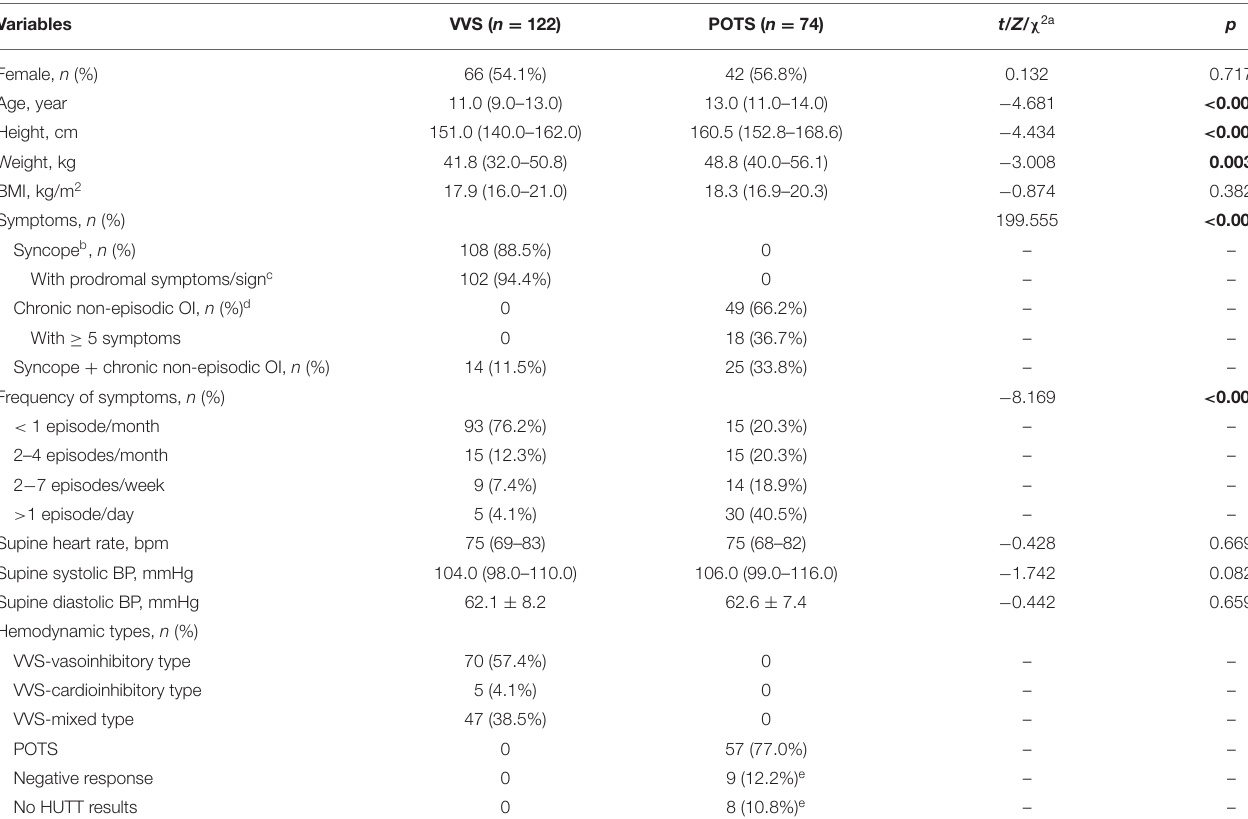
TABLE 1 | Comparison of baseline characteristics between VVS and POTS cases in derivation